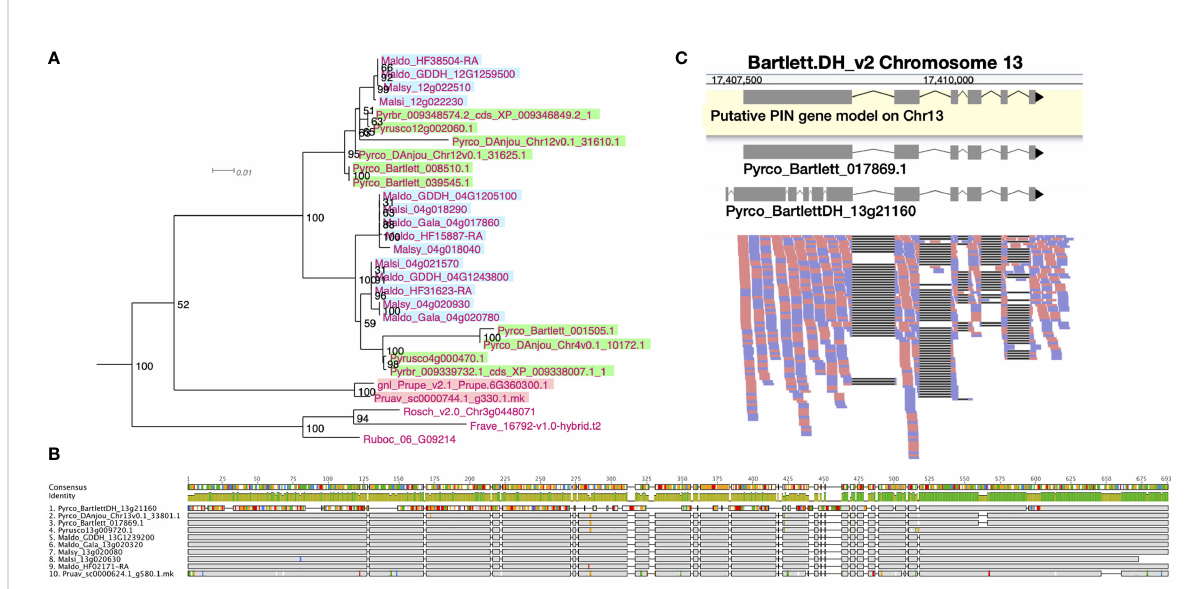
FIGURE 3 Phylogeny, amino acid sequence comparison, and RNAseq read mapping of PIN genes. (A) One clade of short PINs from OG1145 phylogeny. Malus genes are indicated with a blue background, Pyrus with a green background, and Prunus with a pink background. (B) Amino acid sequence alignment of orthologous genes from 10 Amygdaloideae species in the long PIN gene family (OG438). Sites identical to the consensus are shown in gray and sites different from the consensus are shown with a color following the Clustal color scheme in Geneious R9. Green color in the identity row indicates 100% identical across all sequences and greeny-brown color indicates identity from > 30% to < 100% identity. Gaps in the alignment are shown with a straight line. (C) RNAseq reads (forward: red; reverse: blue) mapped to a fragment of chromosome 13 in the Bartlett.DH_v2 genome, where a long PIN gene, Pyrco_BartlettDH_13g21160 , was annotated. The gene model in the yellow box is a putative gene model predicted with RNAseq reads mapped to this region. The two gene models above the read mapping are retrieved from the original annotations of Bartlett_v1 ( Pyrco_Bartlett_017869.1 ) and Bartlett.DH_v2 ( Pyrco_BartlettDH_13g21160